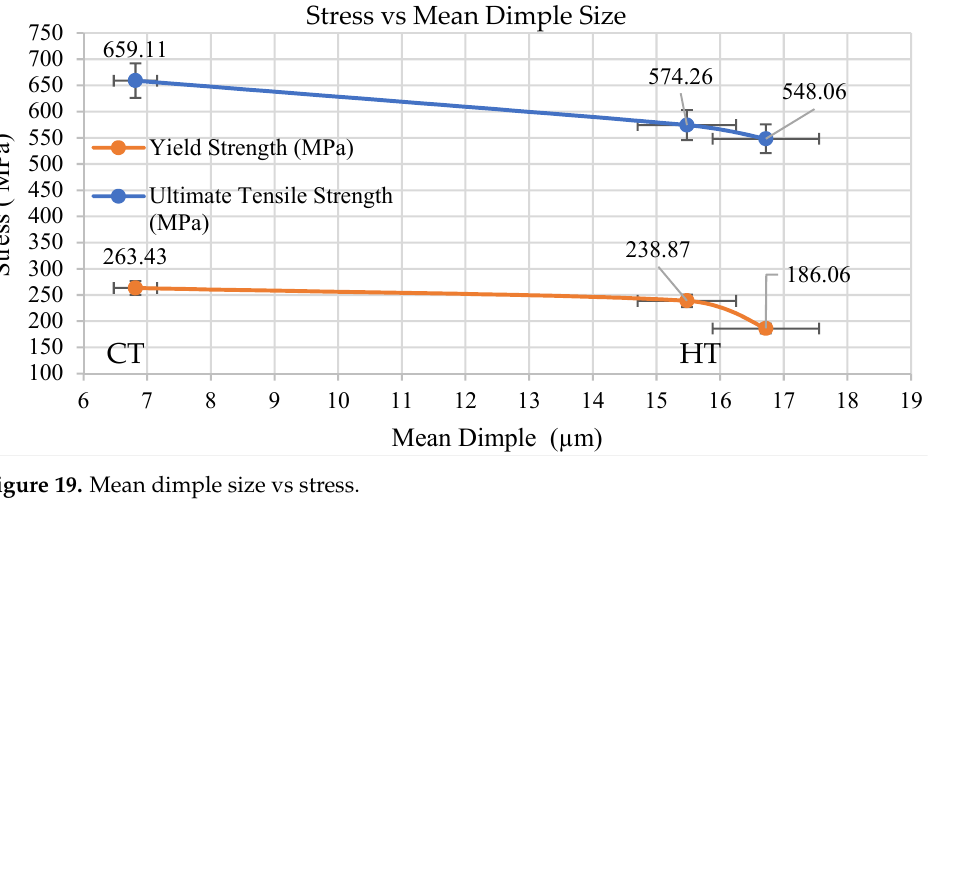
Figure 20. Mean dimple size vs % elongation. 7. Conclusions Monel 400 and SS 316L dissimilar metal welding was carried out using GTAW and joints were subjected to post weld treatment and deep cryogenic treatment. Tensile testing was carried out experimentally and digital image correlation was performed to analyze strains at different zones of weld region. Scanning Electron Microscopy was used to ana- lyze the fracture surface. 1. CT specimen has more ultimate strength and % Elongation compared to HT and UT specimens. CT specimen has 16.48 and 12.87% more tensile strength when compared to UT and HT specimens. The % Elongation of CT was 27.81 and 13.73% more than UT and HT specimens, respectively. 2. The local strain values are predicted for five stages from loading to fracture for UT, HT, CT specimens using DIC. In CT, Maximum strain value of 44.31% was observed for SS 316L HAZ. The deformation was localized rapidly at the necking region on the SS 316L HAZ side until failure. Similar effects were noticed in HT and UT specimens also. 3. The strain distribution at necking region for UT, HT, CT specimens along distance from weld center line was predicted. The local strain for all specimens before yielding on